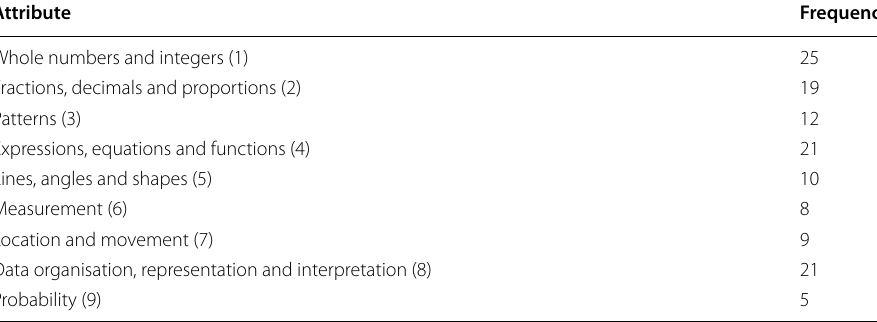
Attributes and frequency adopted from Johnson et al. (2013)